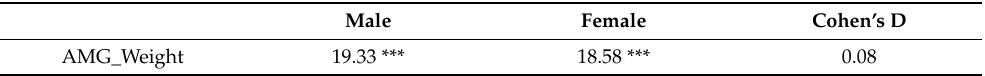
Table 7. Adjusted Morbidity Group (AMG) variables of persons over 65 years of age living alone based on sex. Basic Health Areas of Gran Canaria. 2018–2020. Medians. Male Female Cohen’s D AMG_Weight 19.33 ***